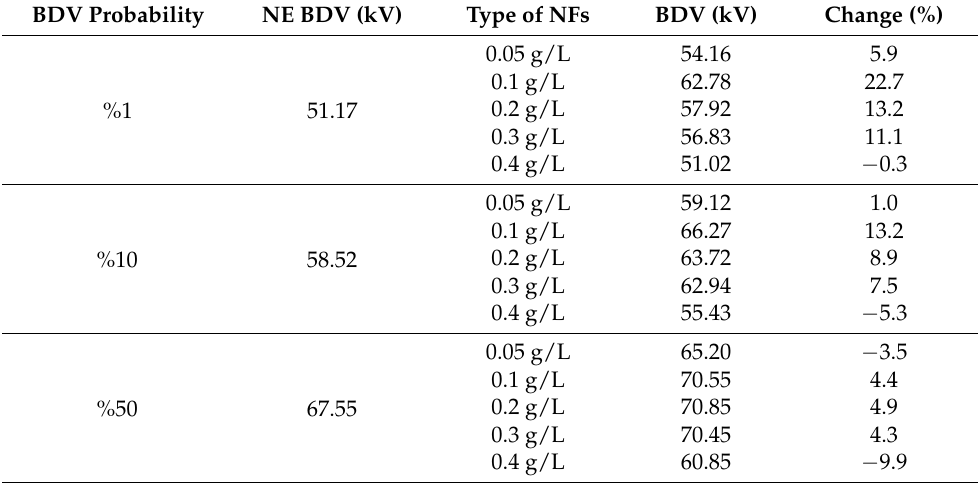
Table 4. AC breakdown withstand voltages at different probabilities for NE and